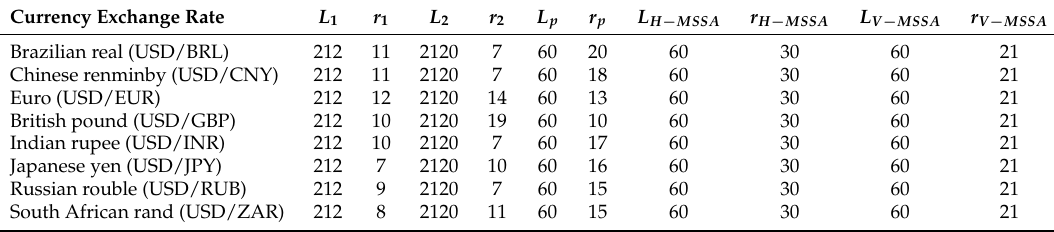
Table 3. Window length L 1 = N /20, L 2 = N /2 and L p , and number of eigentriples r considered for model fit and model forecast for each of the currency exchange